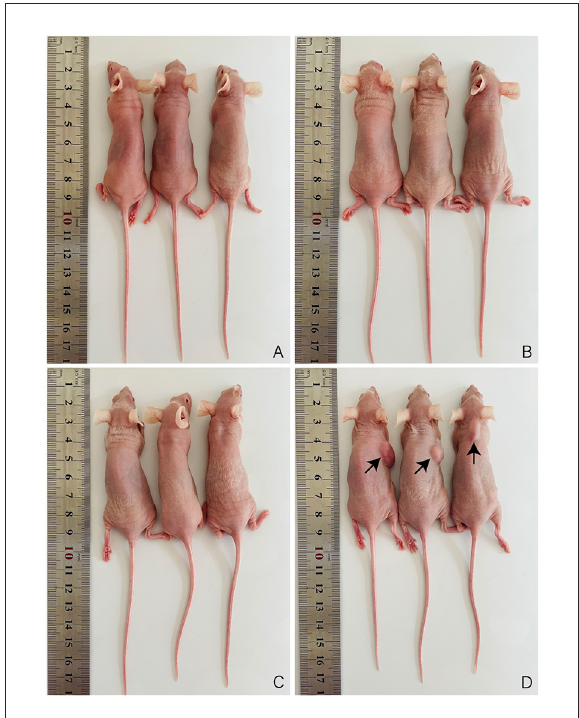
FIGURE4 Immortalized OFTu cell line is not available with tumorigenic ability. Xenograft assay was performed to evaluate tumorigenic capacity of PBS (A) primary OFTu cells (B) immortalized OFTu cells (C), and HeLa cells (D)